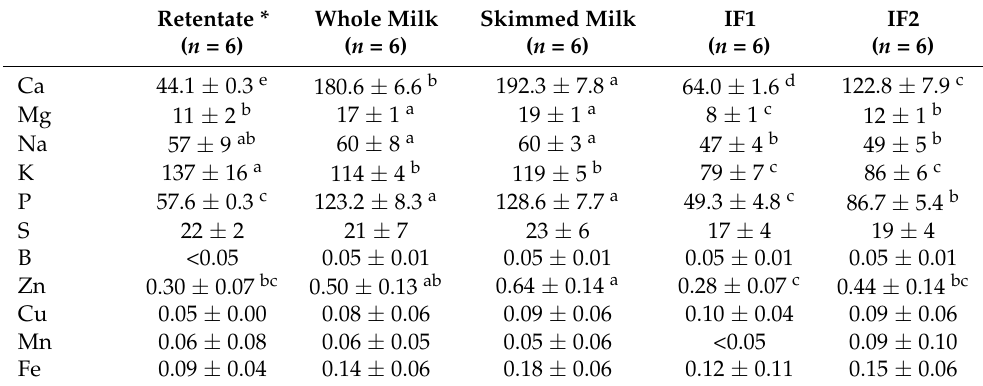
Table 4. Mineral composition (mg 100 g − 1 ) of milk ingredients and of the two resulting liquid milk-derived formulations IF1 and IF2, to be used in the production of first stage (from 0 to 6 months of age) and follow-on (from 6 to 12 months of age) infant formulae, respectively (mean ± SD). Retentate * Whole Milk Skimmed Milk IF1 IF2 ( n = 6) ( n = 6) ( n = 6) ( n = 6) ( n = 6) Ca 44.1 ± 0.3